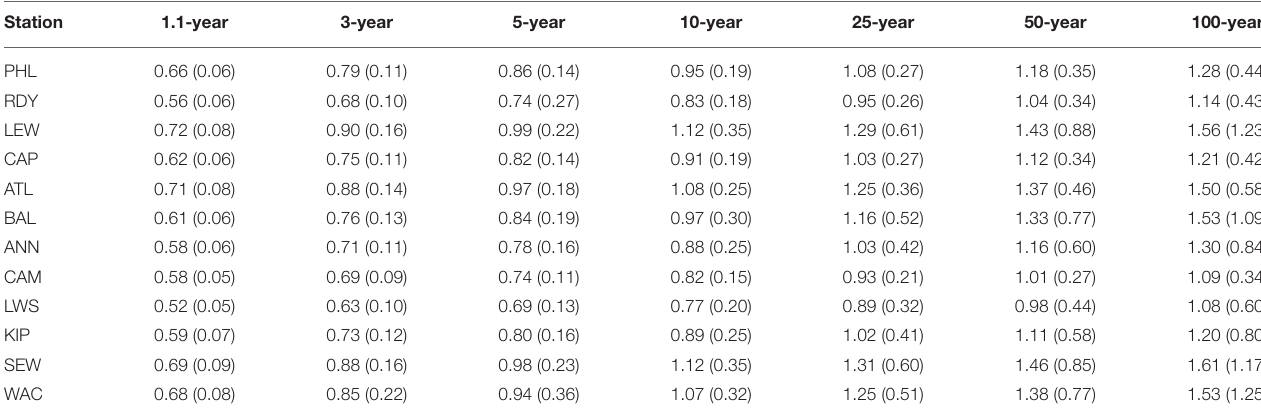
TABLE 6 | Estimated skew surge return levels for 1.1, 3, 5, 10, 25, 50, and 100-year return periods modeled using the POT/GP approach for tide gauges in the Mid-Atlantic region.